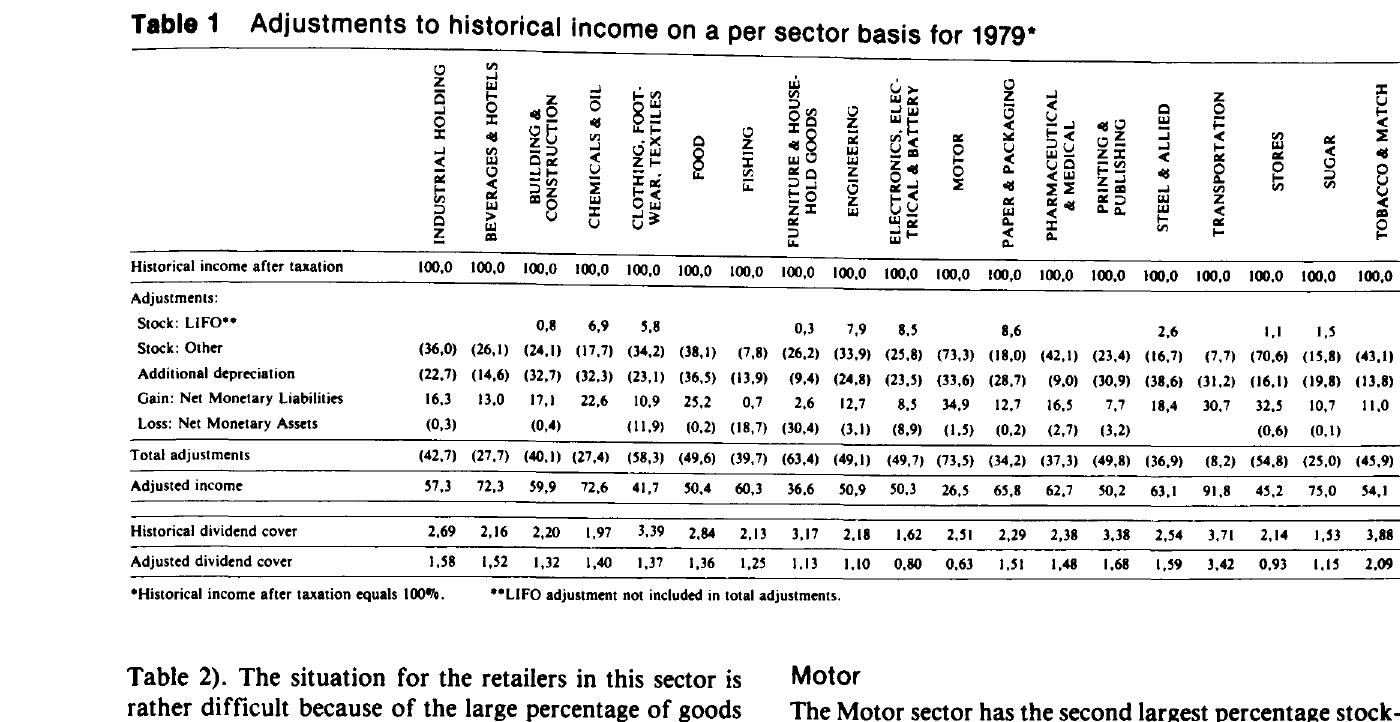
Balance sheet per sector for 1979 (in